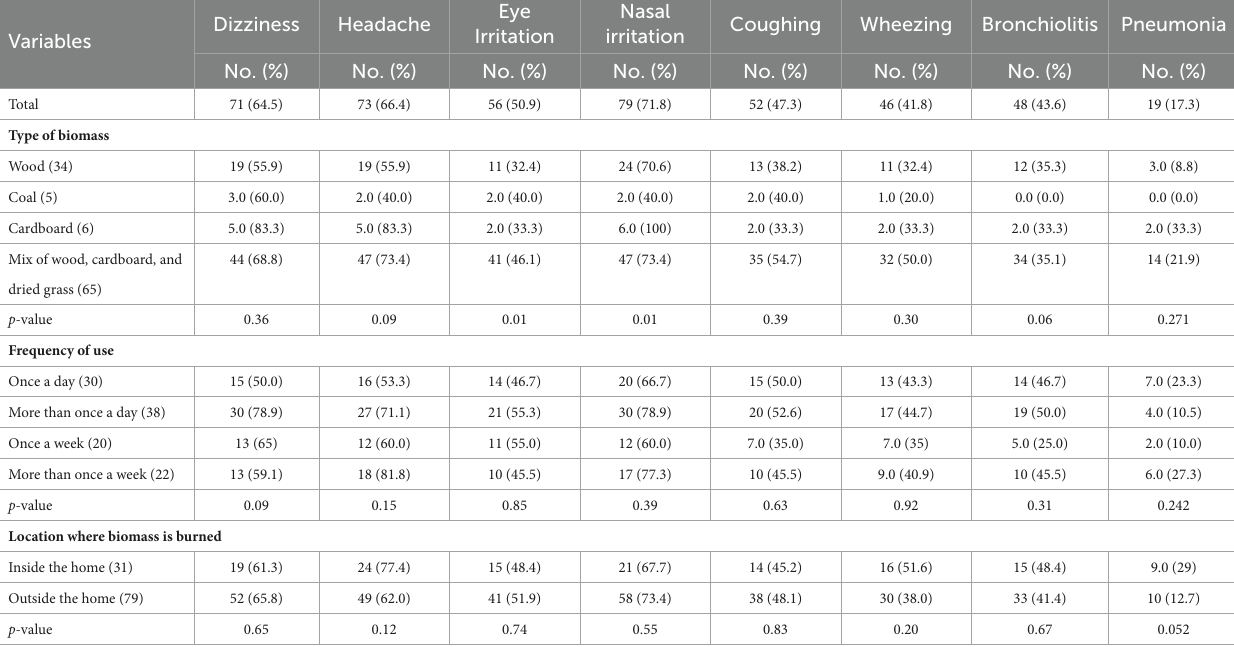
TABLE 6 Association between types, frequency, and location of biomass fuel used with common symptoms/morbid among respondents.